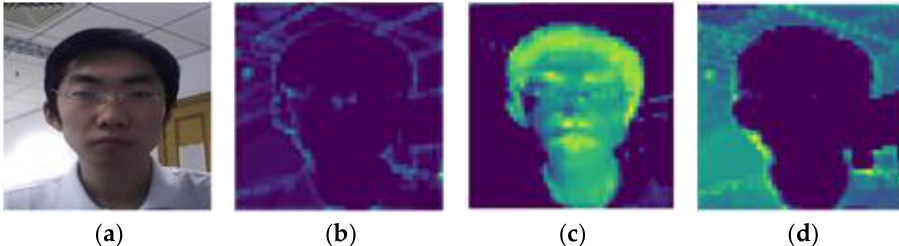
Figure 2. Face image feature map of the fourth ResNet50 convolution layer output. ( a ) Original image; ( b – d ) face feature map.